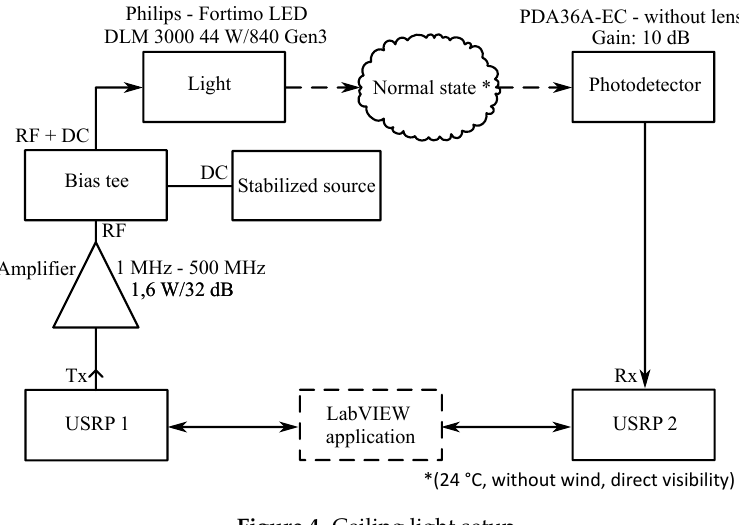
Figure 4. Ceiling light setup.